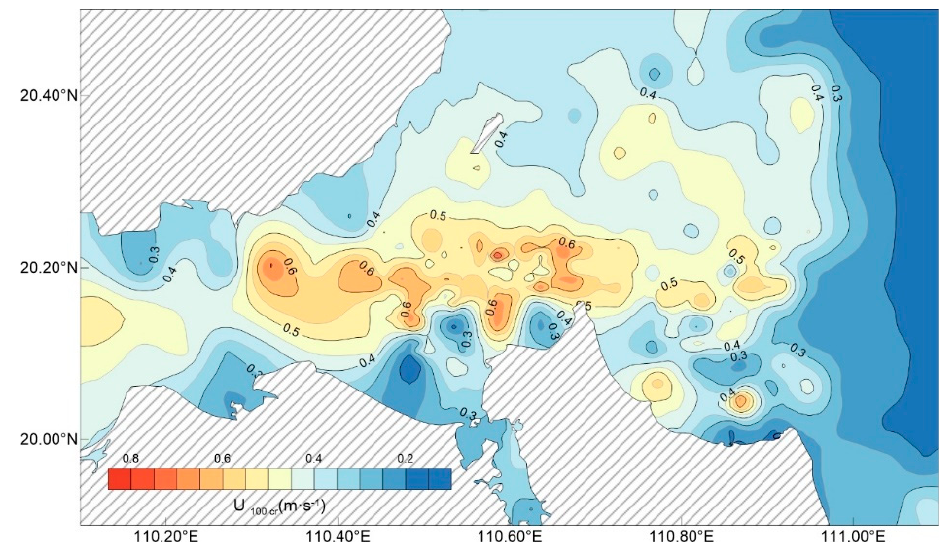
Figure 3. Distribution of grain size parameters, ( A ) mean grain size contours with an interval of 0.5 phi, ( B ) sorting contours with an interval of 0.2.